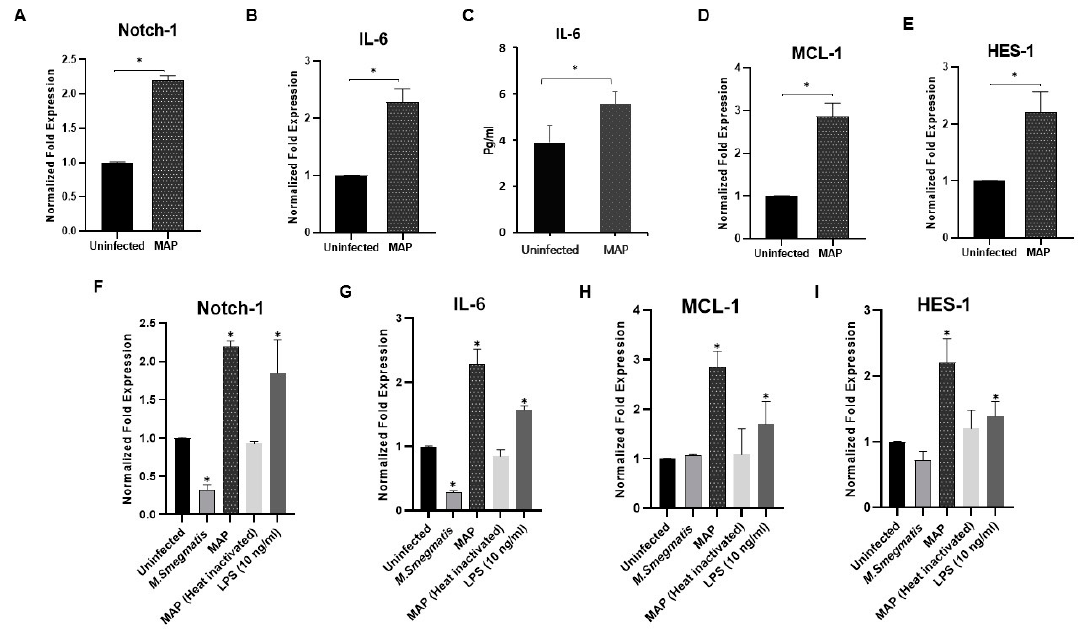
Figure 1. Mycobacterium avium paratuberculosis (MAP) induces expression of Notch-1, IL-6, and myeloid cell leukemia sequence-1 (MCL-1) in infected macrophages. ( A – E ): Expression level of Notch-1, interleukin (IL)-6, MCL-1, and hairy enhancer of split (HES)-1 was measured in infected macrophages using MAP (UCF 4, 10 7 CFU / mL) for 24 h. ( F – I ): Expression level of Notch-1, IL-6, MCL-1, and HES-1 in macrophages infected with M. smegmatis, MAP, heat-inactivated MAP, and lipopolysaccharide (LPS) (10 ng / mL). Gene expression levels were measured using RT-PCR. IL-6 protein level was measured using Enzyme-linked Immunosorbent Assay ELISA. All experiments were performed in triplets. Data are shown as mean ± SD, and significance is considered as * p < 0.05.